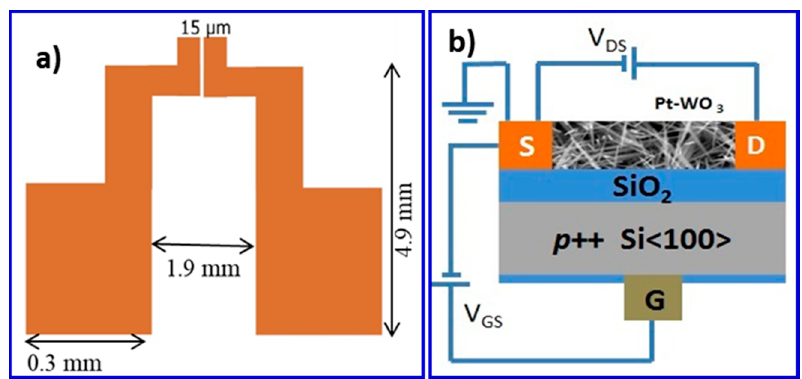
Figure 1. ( a ) 15 µm gapped interdigitated gold electrodes for source-drain contacts; ( b ) back-gated sensor configuration with back gate electrode and active sensing material between source-drain